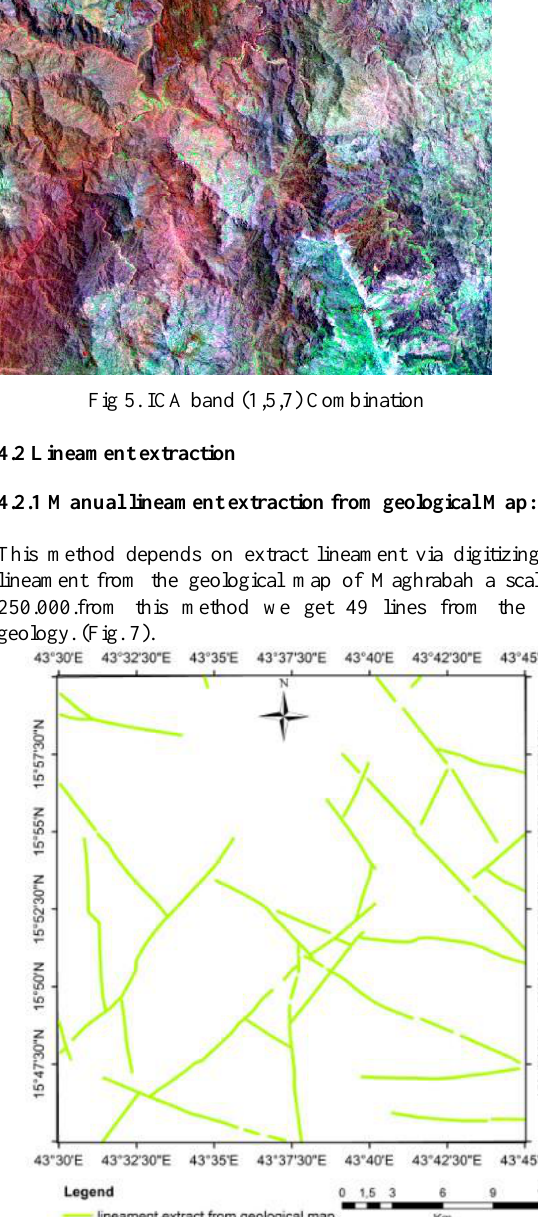
Figure 7. Lineament extraction from geological map